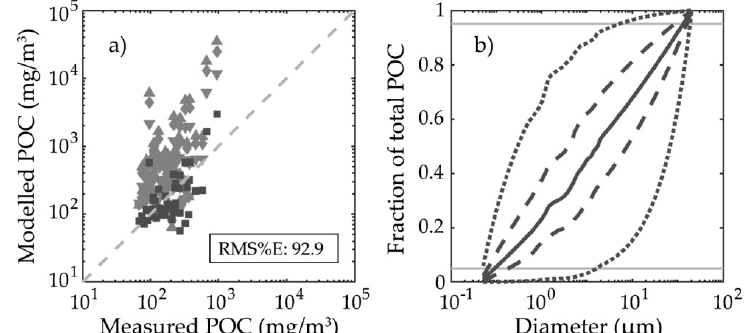
Figure 7. ( a ) Comparison of modelled vs. measured POC. POC values calculated using the diatom model (Menden-Deuer & Lessard, 2000) are represented by dark grey squares; the RMS%E value refers to these. POC values calculated using the other three models are represented by light grey diamonds and triangles; ( b ) Cumulative distribution of modelled POC for the diatom model. Solid, dashed, and dotted lines represent median, upper/lower quartiles, and max./min. values respectively. The light grey horizontal lines mark the middle 90% of the contribution (i.e., from 5% to 95%) to the total POC value. The dashed grey line indicates the 1:1 relationship.